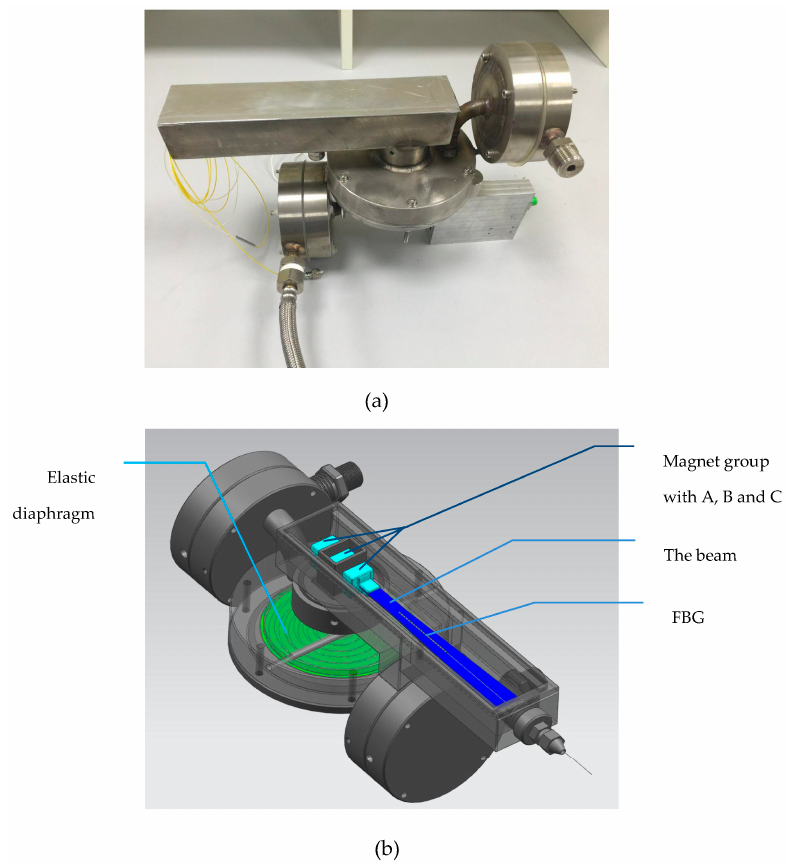
Figure 8. ( a ) The real sensor; ( b ) The structure inside the sensor.